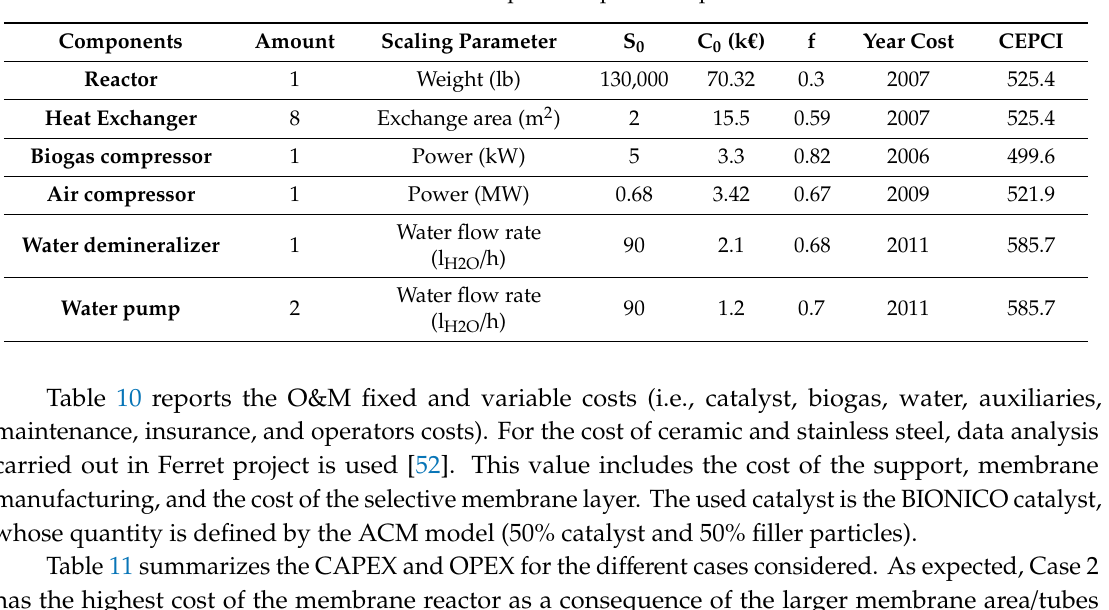
Table 9. Cost assumption for plant